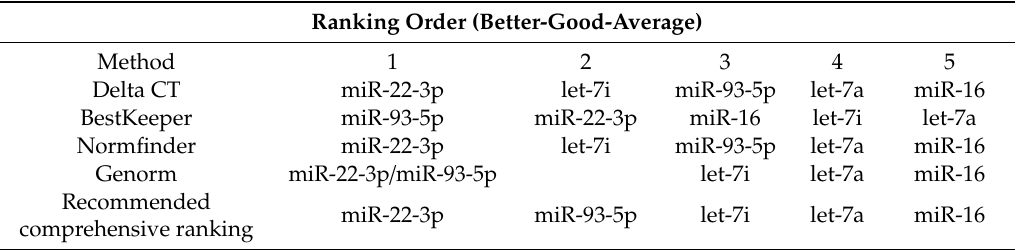
Table 9. Overall stability ranking order of miRNAs. MiR-22-3p and miR-93-5p were first and second in ranking order, whereas miR-16-5p was the least